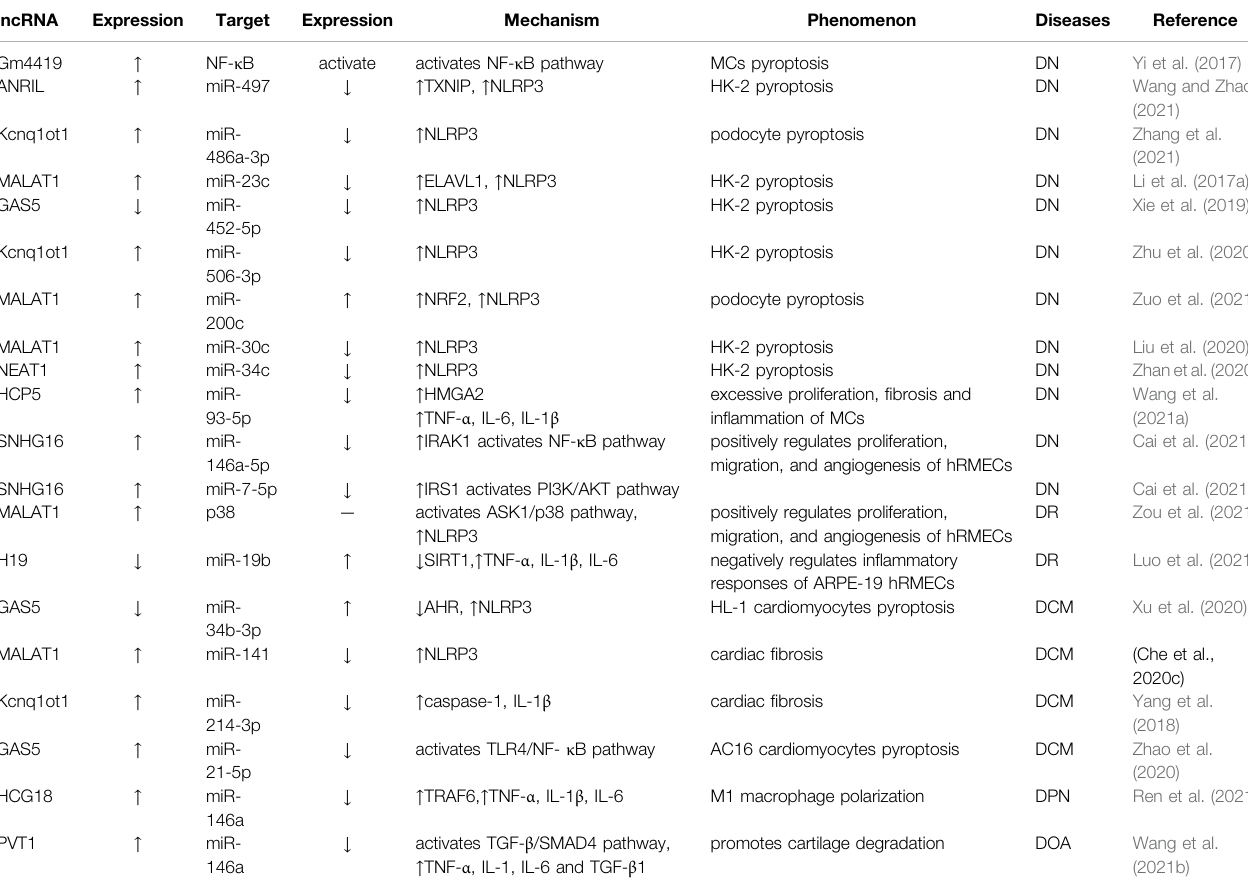
TABLE 2 | LncRNAs regulating NLRP3 in fl ammasome in diabetes complications.